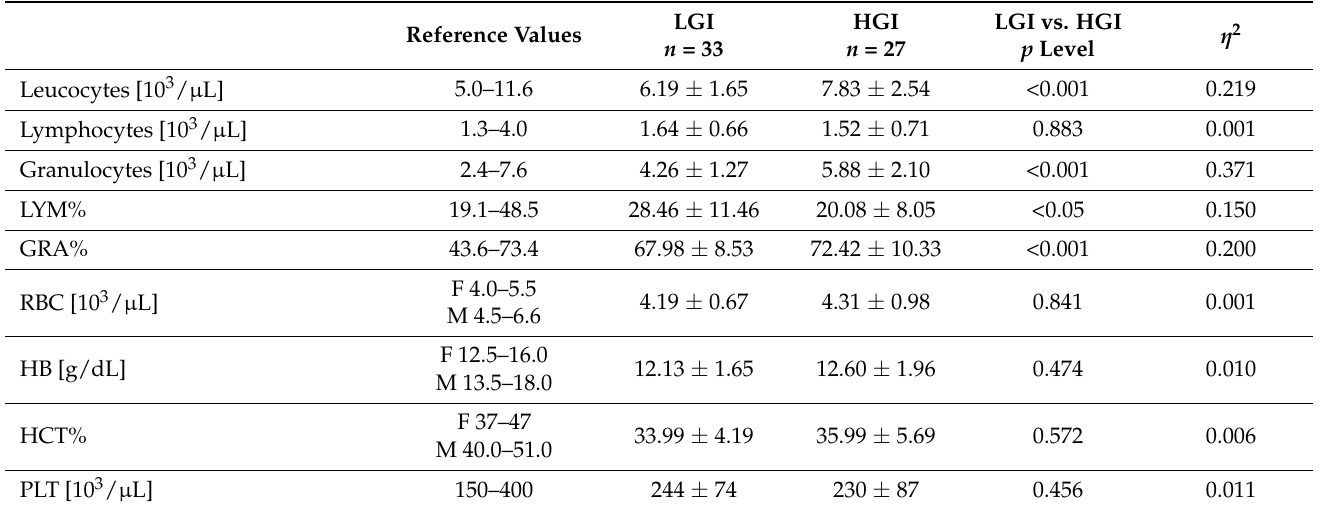
Table 4. Haematological variables (mean ± SD).